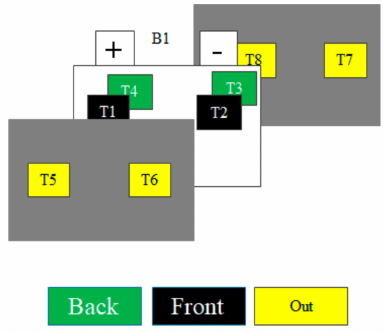
Figure 2. Schematic representation of thermocouples on battery and phase change material (PCM) surfaces.